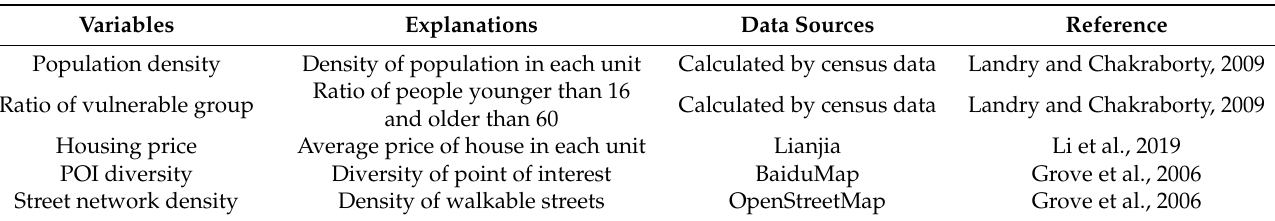
Table 2. Selected